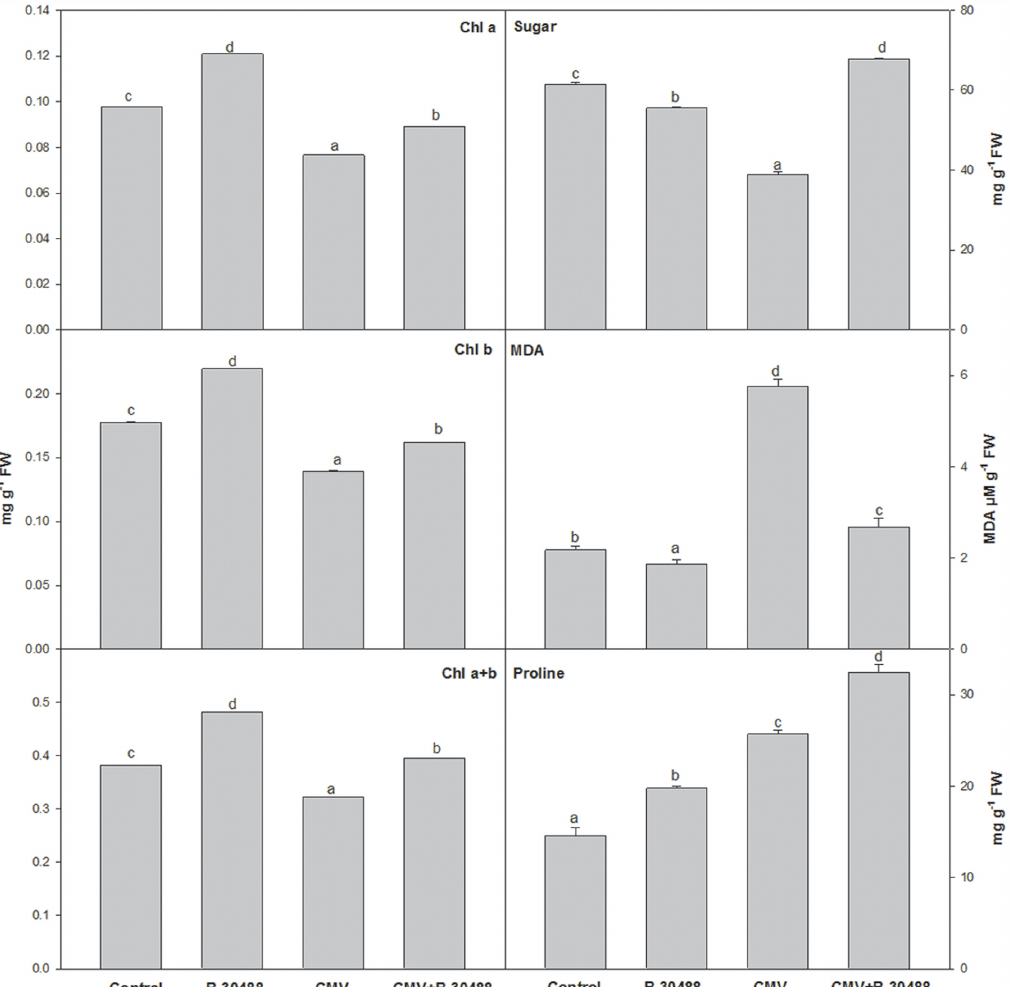
Fig 3. B-30488 inoculation improved the biochemical characters in tobacco plants. Graphs for biochemical (chlorophyll, sugar, proline and MDA) characters in systemic leaf of N . tabacum cv. White Burley plant collected from each treatment (Control, B-30488, CMV and B-30488+CMV) revealing the improved plant efficiency in bacterized plant. The data was calculated at 28